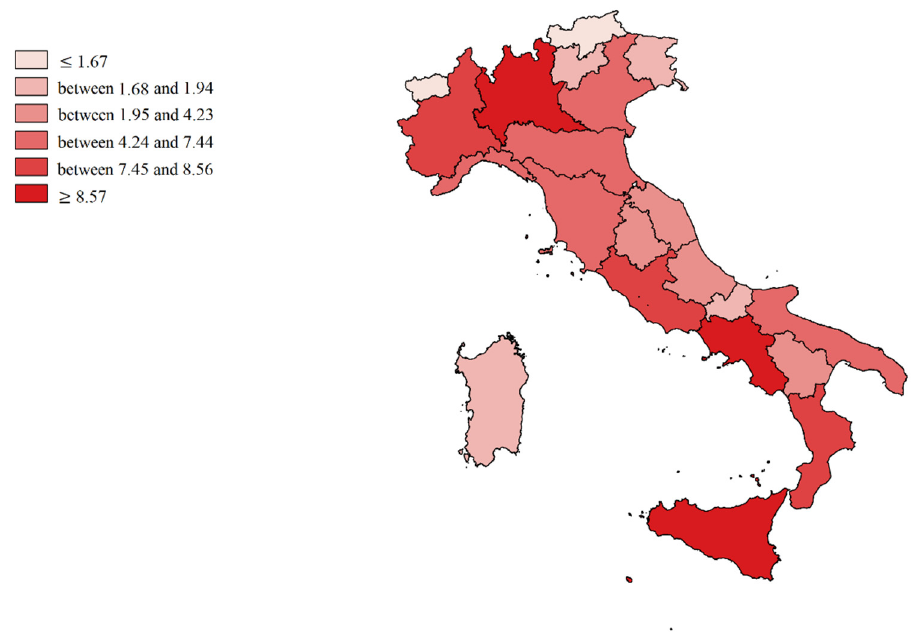
Figure 6. Cartographic representation of regional Escape Production Indexes (EPI), mean from 2013 to 2017